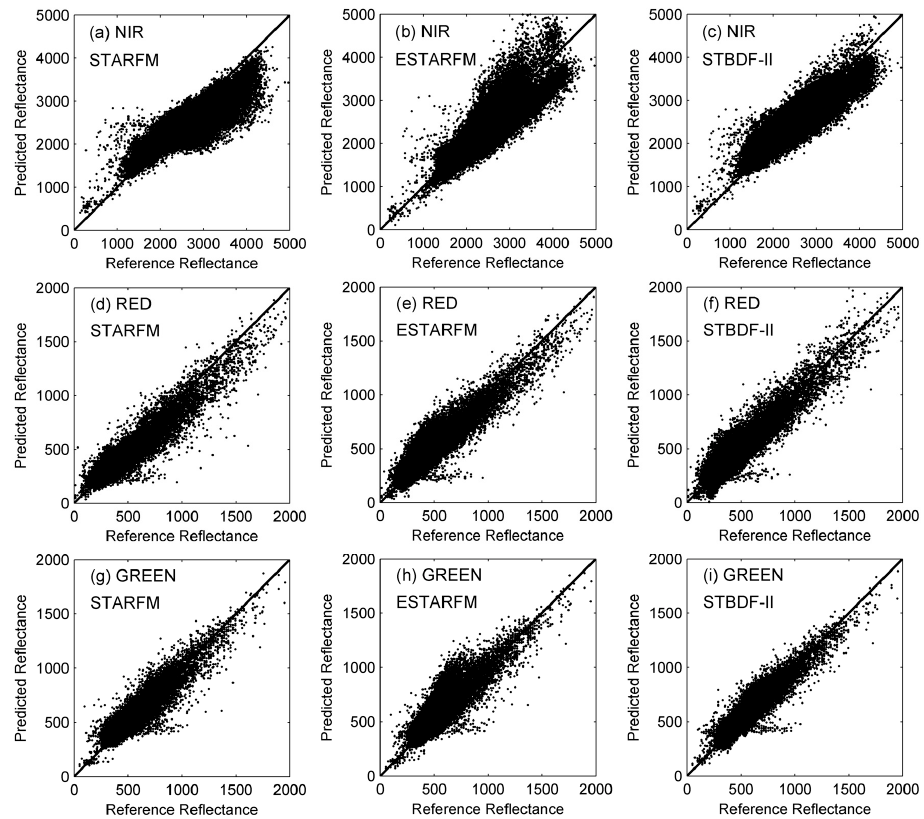
Figure 7. Scatter plots of the predicted reflectance against the actual reflectance. ( a – c ) Scatter plots of the predicted reflectance using STARFM, ESTARFM, and STBDF-II against the actual reflectance in the NIR band, respectively; ( d – f ) the red band; ( g – i ) the green band.